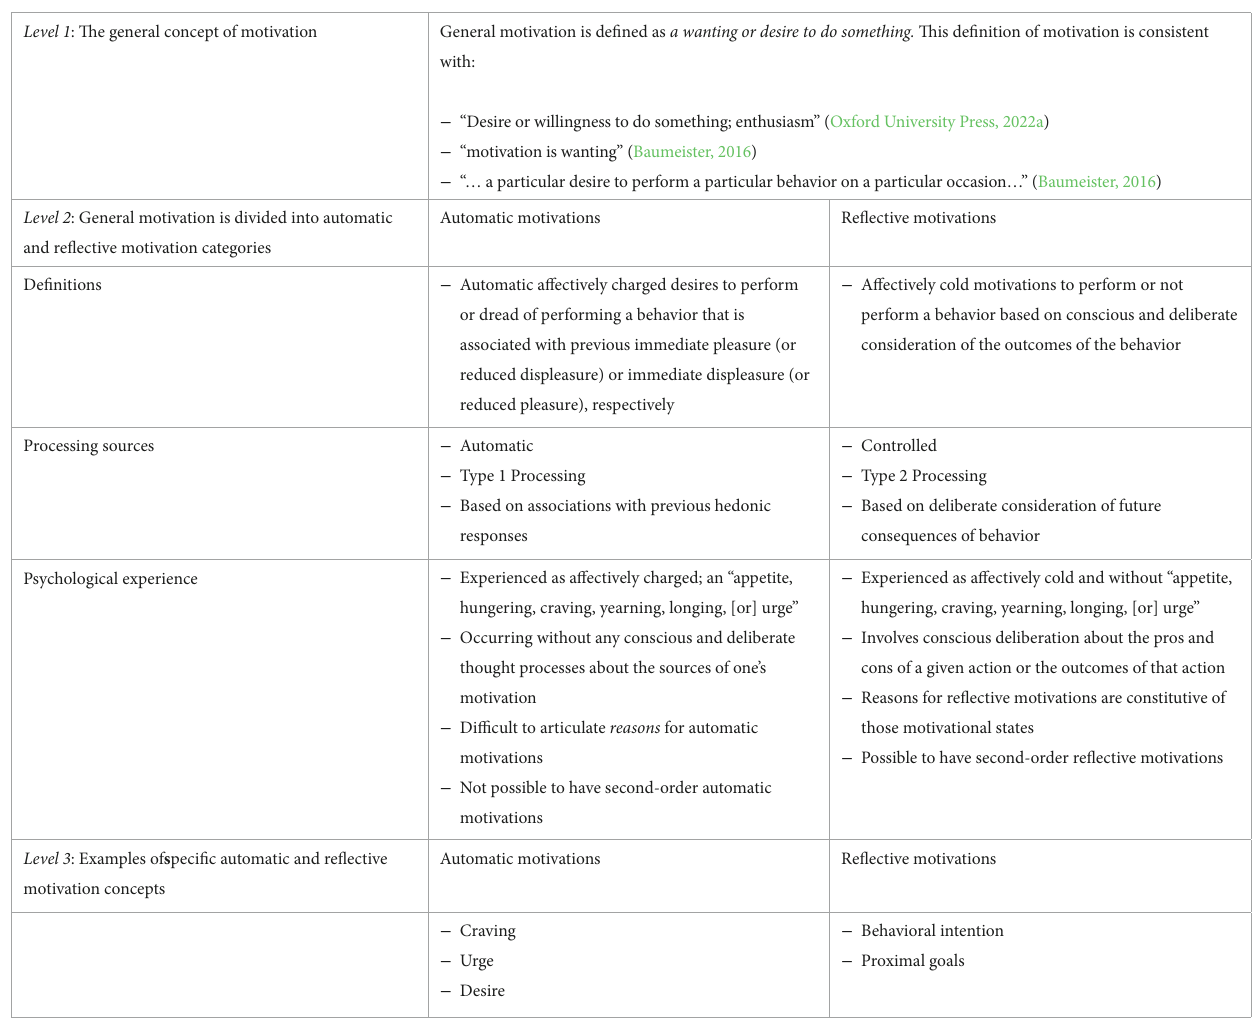
TABLE 1 Components of the automatic-reflective motivation